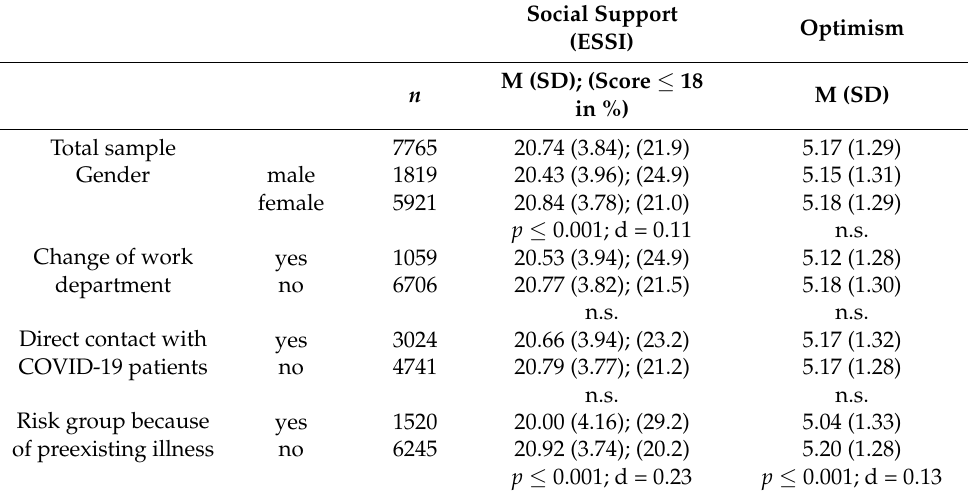
Table 5. Social support and general optimism among the sample of healthcare